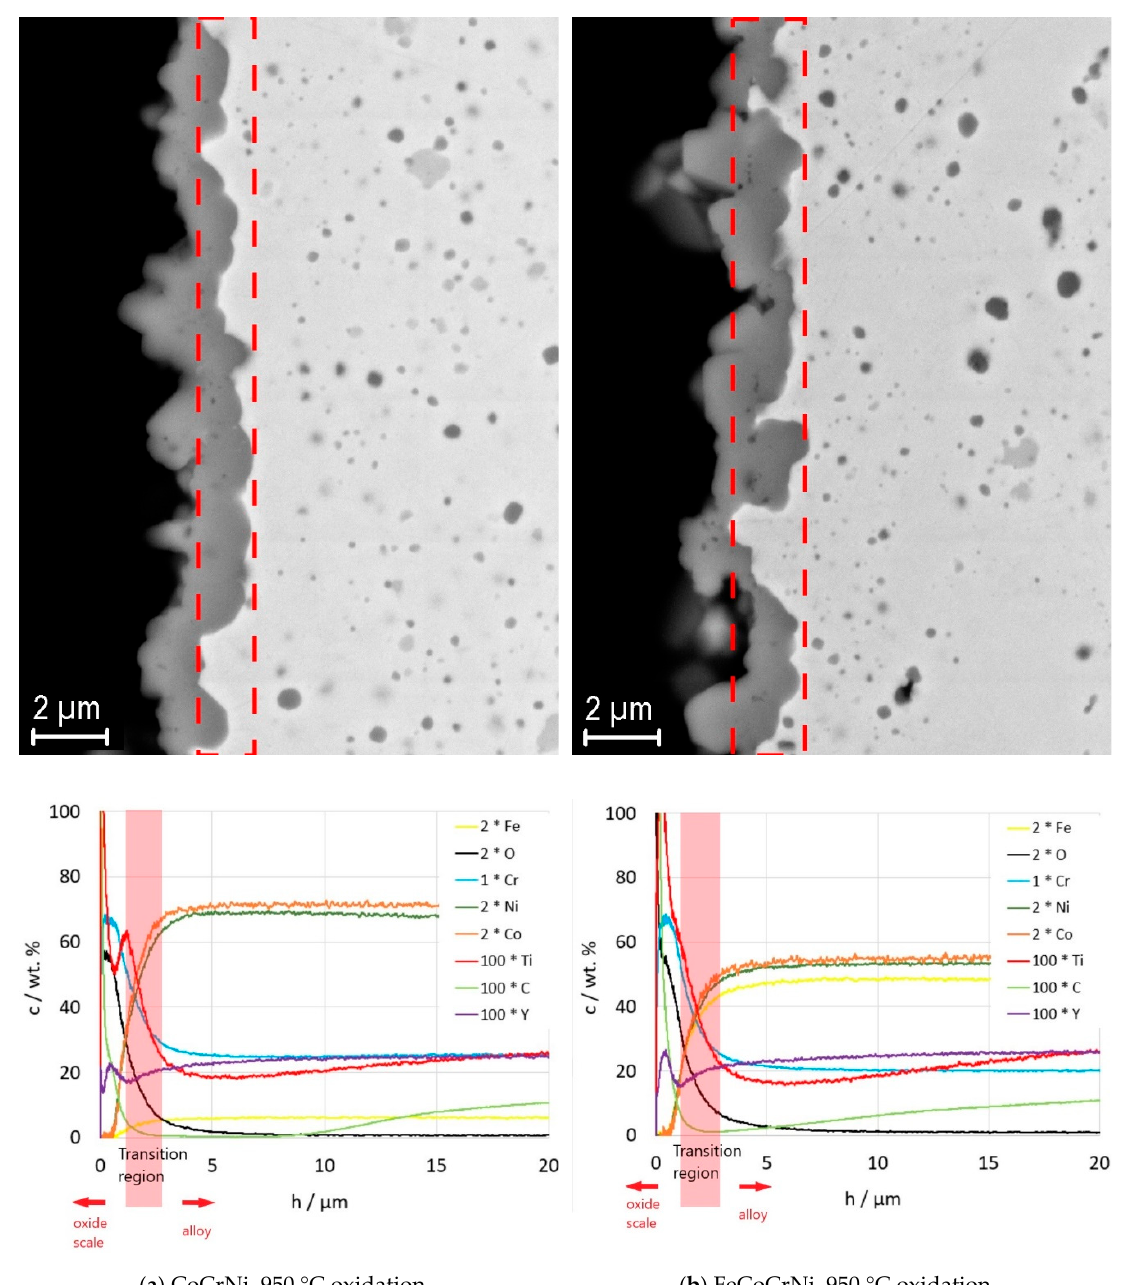
Figure 6. SEM images (backscatter mode) of the oxide scales coupled with plots of elemental distribution in the oxide scale and in the adjacent alloy region measured by GDOES. The actual concentration of the element is multiplied by the factor described in the legend. The results refer to 150 h of oxidation at 950 °C.